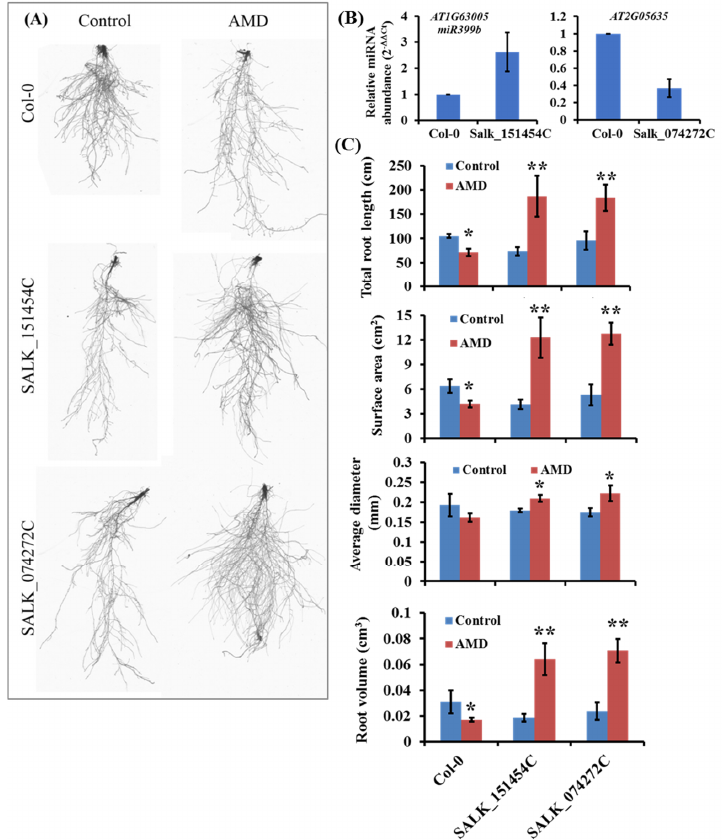
Figure 3. Phenotypic variation of T-DNA mutants of candidate genes in low pH stress condition. ( A ) Representative images of the phenotypic variation root length in wild type Col-0, Salk_151454C, and Salk_074272C T-DNA mutant seedlings in response to the control and AMD conditions. ( B ) Expression of miR399b and DNA helicase RAD3 genes in the corresponding T-DNA insertion lines. ( C ) Quantitative analysis of phenotypic variation of root traits in Salk_151454C and Salk_074272C T-DNA mutant seedlings compared with Col-0 in response to the AMD toxicity. The single and double asterisks indicate the significance at p < 0.05 and p < 0.01, respectively, compared to the